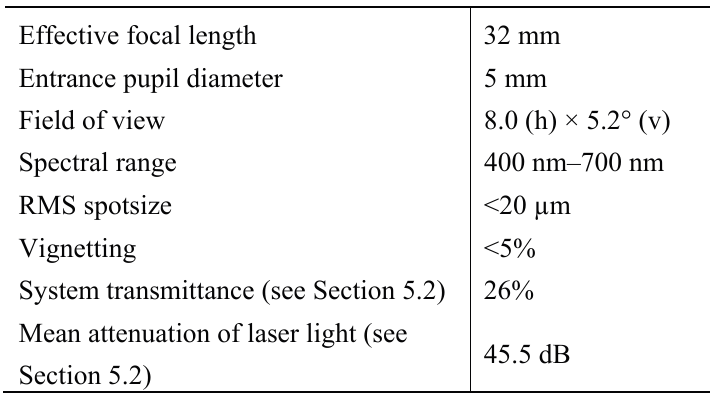
Table 1. Specifications of the complete